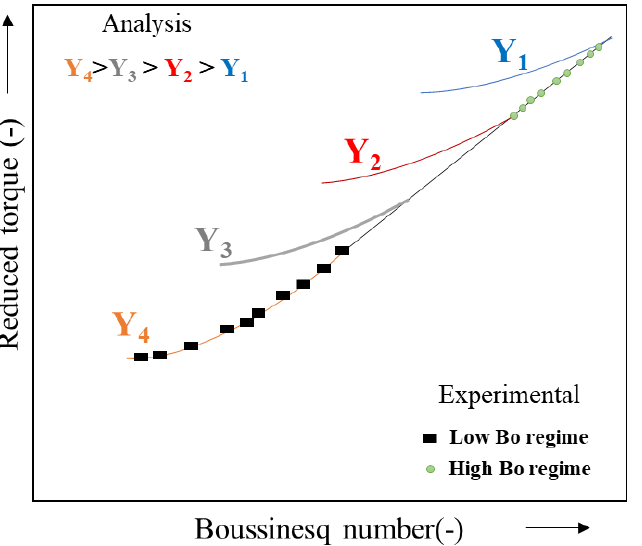
Figure 13. Reduced torque evolution as a function of the Boussinesq number at different bulk viscosity ratios [50]. Copyright 2022 AIP